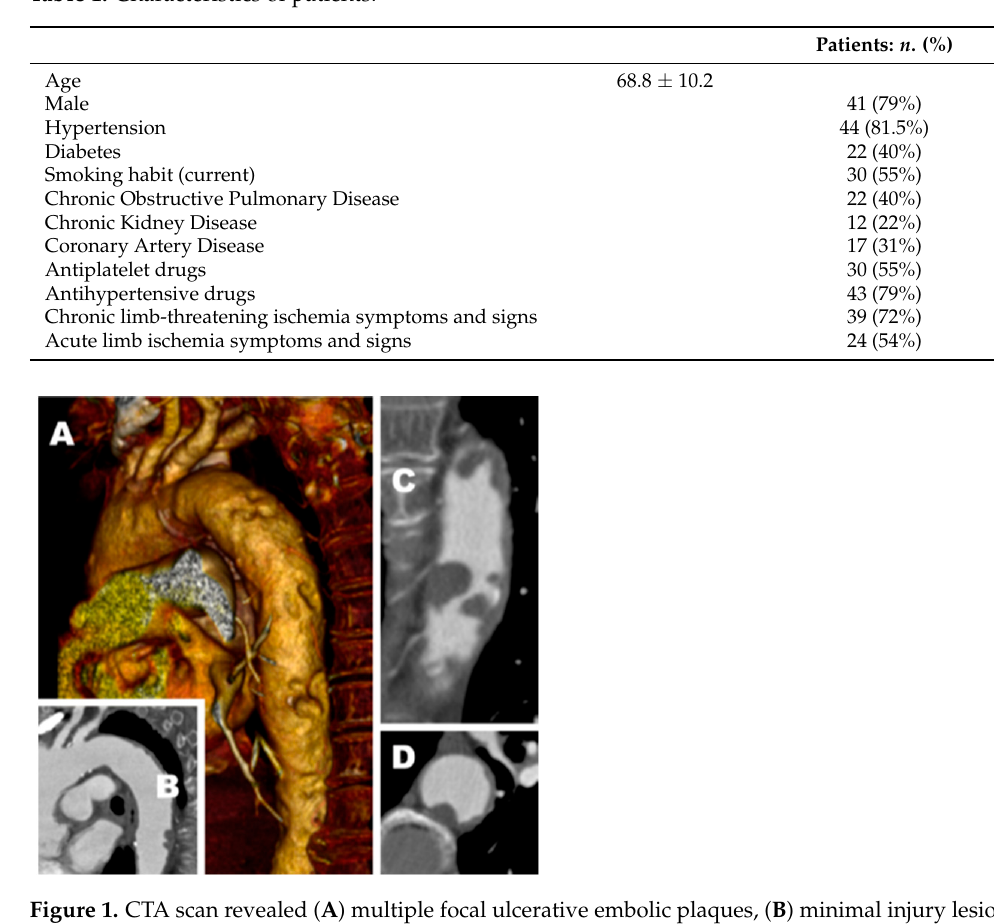
Table 1. Characteristics of patients.